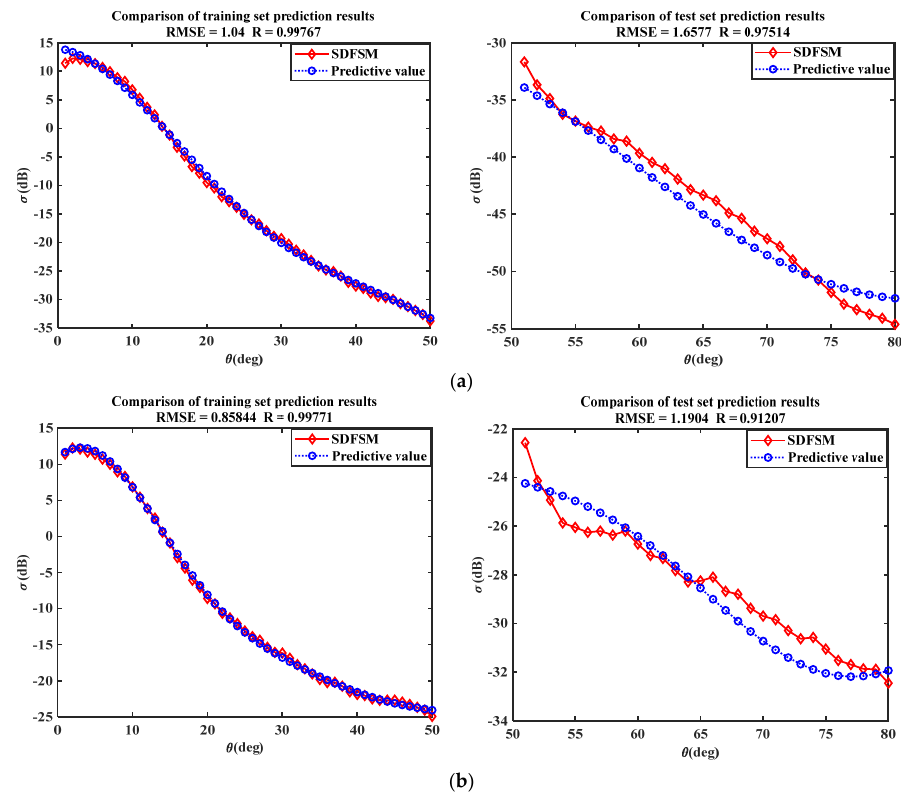
Figure 7. Comparison of the extrapolated prediction results of the PSO-SVR-based prediction model and the simulation results of SDFSM. ( a ) Bestc = 46.8788, bestg = 0.3708, HH polarization. ( b ) Bestc = 43.8788, bestg = 0.9330, VV polarization.